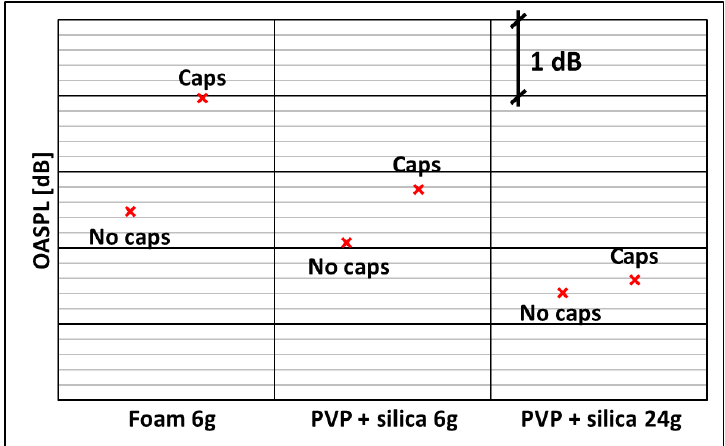
Figure 8. OASPL numerical outcomes for the various headrest configurations.